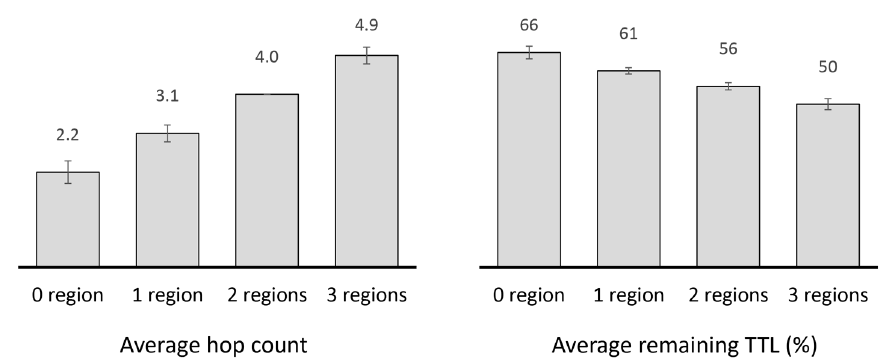
Figure 9. Average hop count and percentage of remaining TTL of delivered messages traversing 0, 1, 2 and 3 regions under high locality with PRoPHET.